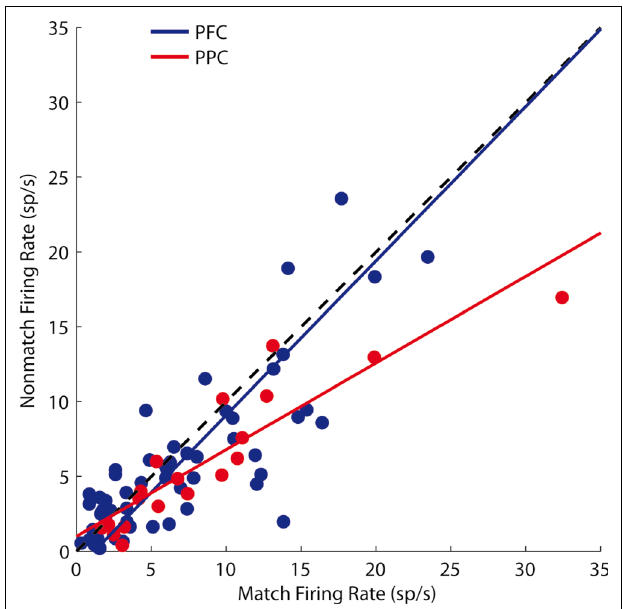
FIGURE 7 | Comparison of responses in the second delay period following a match and nonmatch stimulus, when the cue appeared in the receptive fi eld. Each dot represents a single neuron. One outlier is omitted. Regression lines are shown for the prefrontal and posterior parietal cortex.